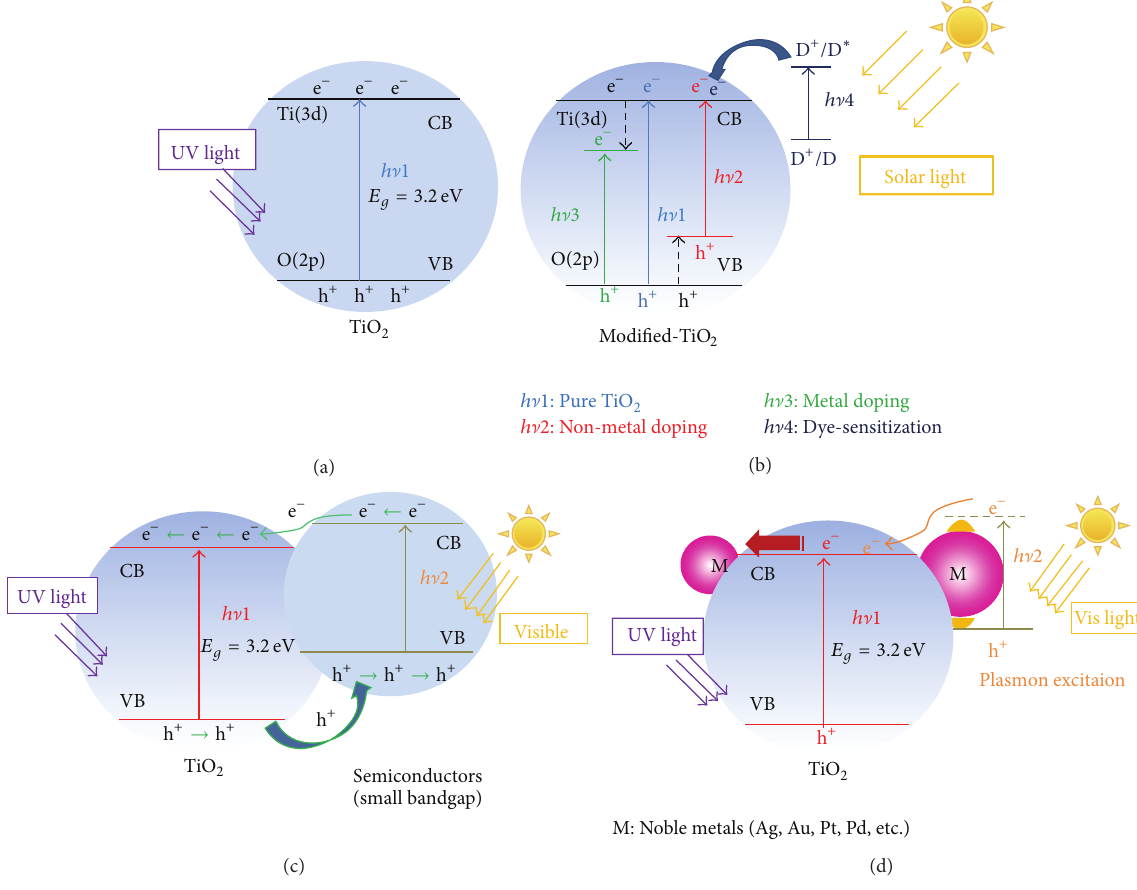
Figure 4: Schematic of energy level of pure TiO 2 (a) and corresponding modification ((b)–(d)). (b) Doping or dye-sensitization, semicon- ductors (c), and noble metals (d)